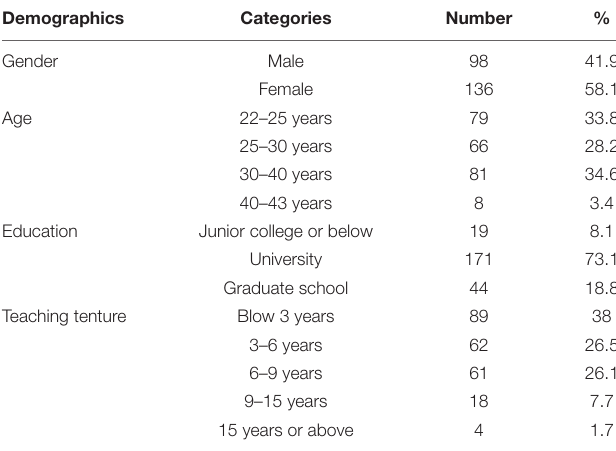
TABLE 1 | Sample characteristics and distribution ( N =